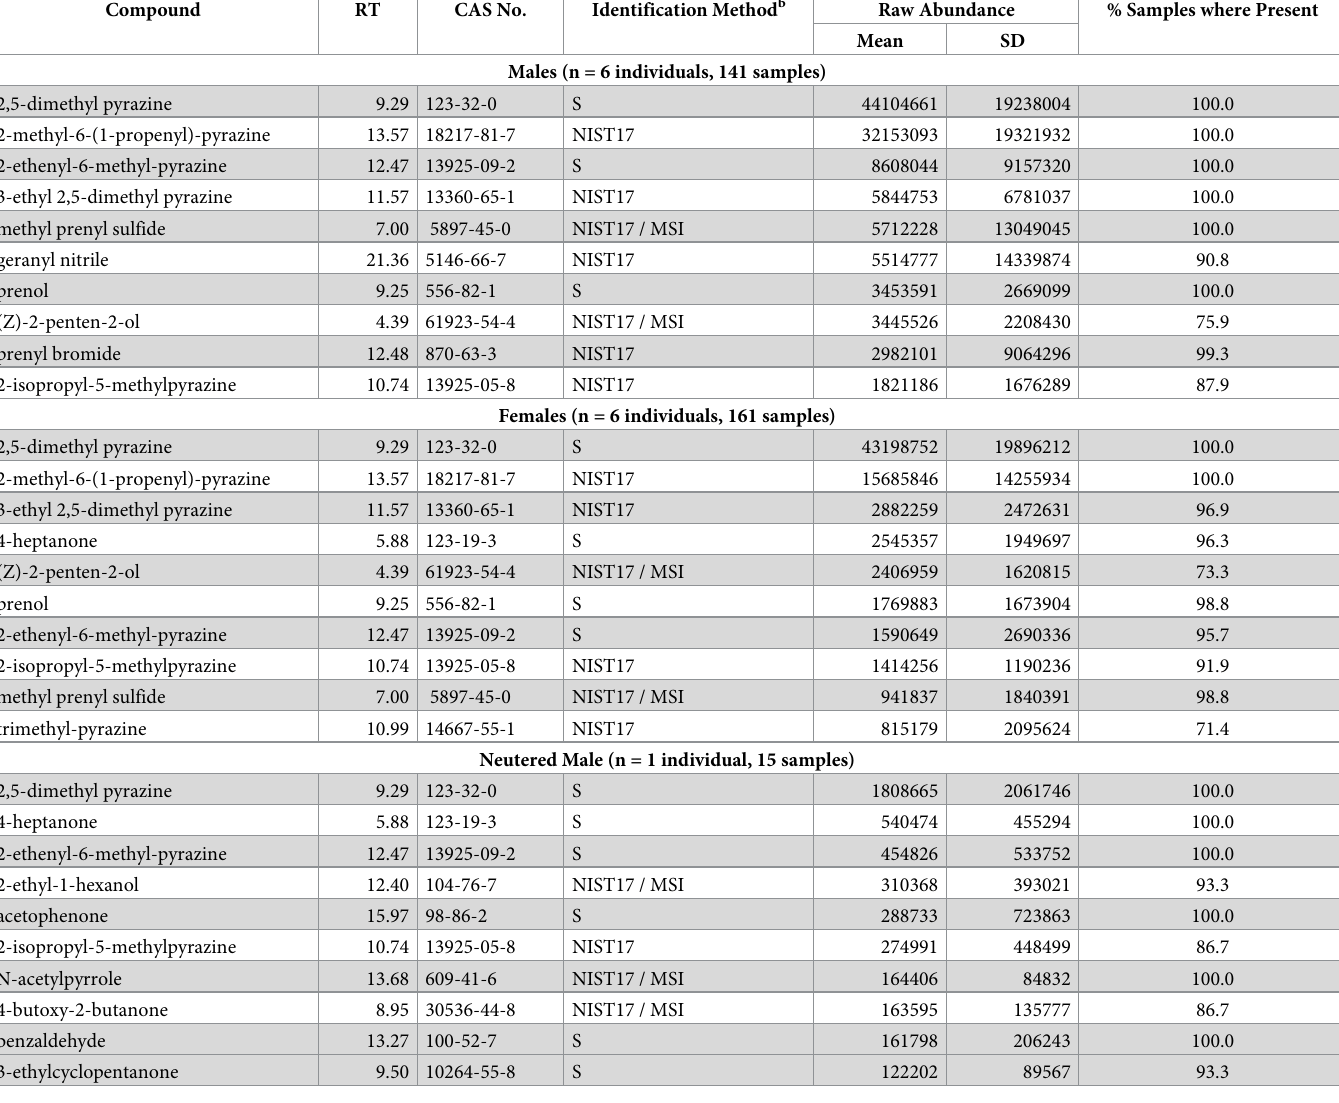
Table 2. VOC found in high abundance and with high frequency across maned wolf urine samples.